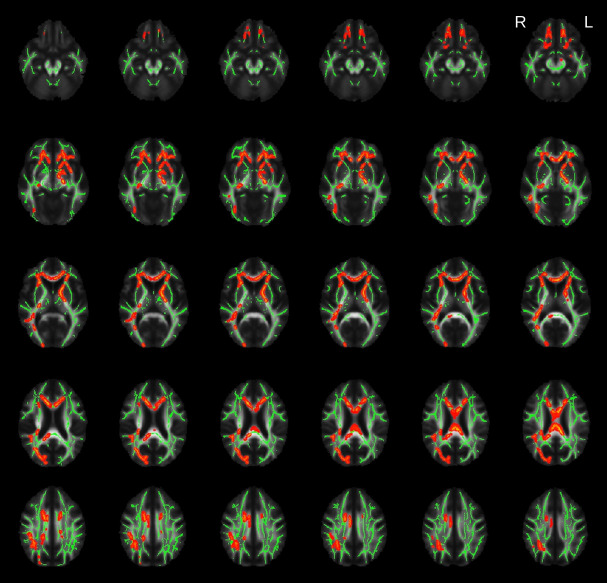
Results of the voxel-wise TBSS analysis.Highlighted clusters (in red) represent significant (family wise error, FWE < 0.05) age corrected negative correlations between fractional anisotropy (FA) and plasma neurofilament light (NfL) protein levels among the patients with behavioural variant frontotemporal dementia (bvFTD). The average skeleton is displayed in green. The results were overlaid onto the study-specific mean FA map.